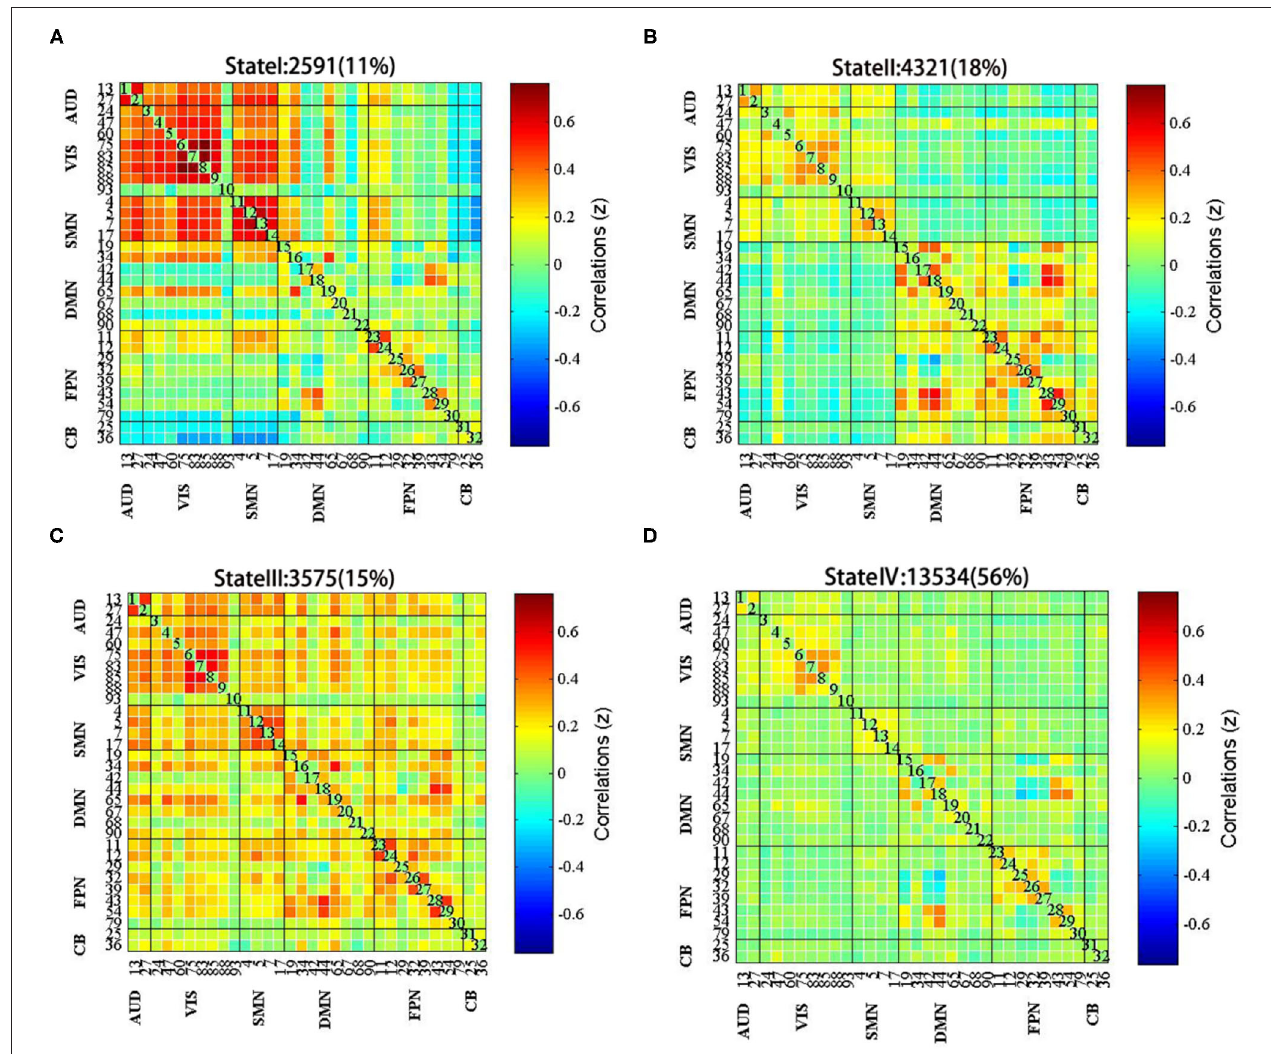
FIGURE 4 | The centroid of each functional network connectivity state with the total occurrences and percentages. (A) State I was mainly characterized by strong connections among AUN, VIS, SMN, and DMN; (B) State II was mainly characterized by strong connectivity within the perceptual networks and high-order cognitive networks; (C) State III was mainly characterized by strong connections between networks; (D) State IV was mainly characterized by weak connectivity among VIS, SMN, and